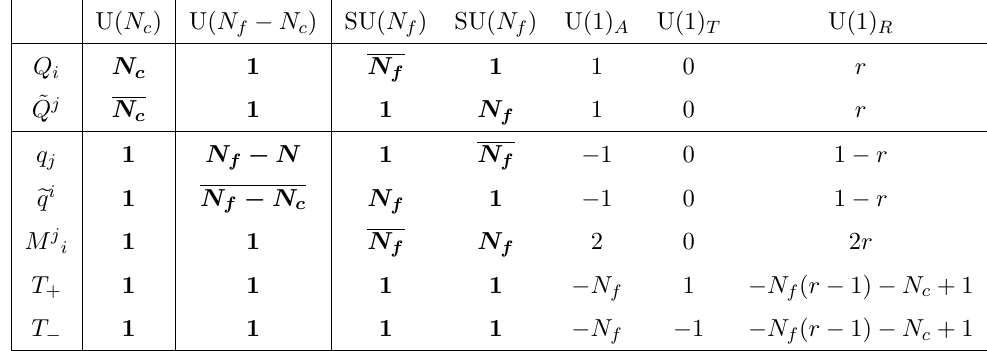
Table 2 . Gauge and (cid:13)avor charges of the chiral multiplets Q; e Q in 3d N = 2 SQCD with U( N c ) gauge group, and of the dual (cid:13)avors q; q and gauge singlet chiral multiplets M; T + ; T (cid:0) in the e Aharony-dual U( N f (cid:0) N c )